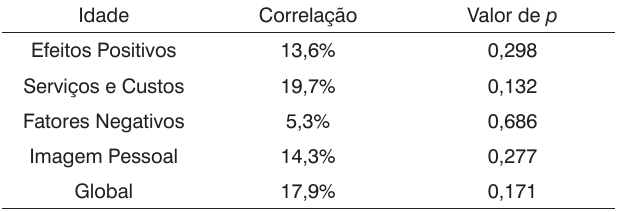
Teste estatístico: Correlação de Pearson; nível de significância p ≤ 0,05. %: Tabela 2. Comparação da satisfação global e por subescala de acordo com o gênero, em pacientes protetizados na Clínica Lumiar avaliados entre setembro e outubro de 2011.